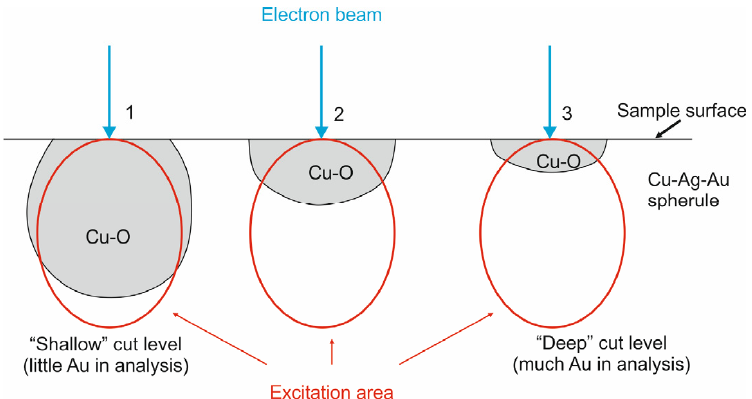
Figure 12. Dependence of gold concentrations in the EDS analyses of Cu-O micro-inclusions from the degree of exposure (cut level) of the individual Cu-Ag-Au spherule (a schematic illustration).